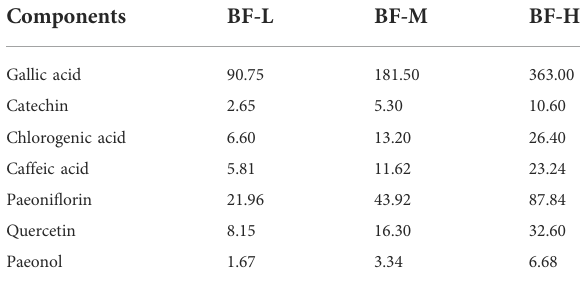
TABLE 3 Concentrations ( μ g/ml) of the seven components in